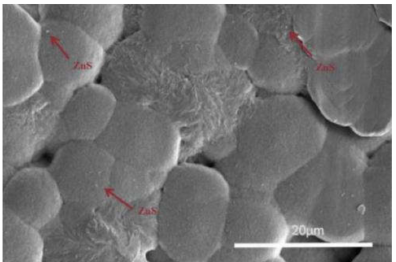
Figure 2. SEM morphology of PVDF/ZnS:Mn thin